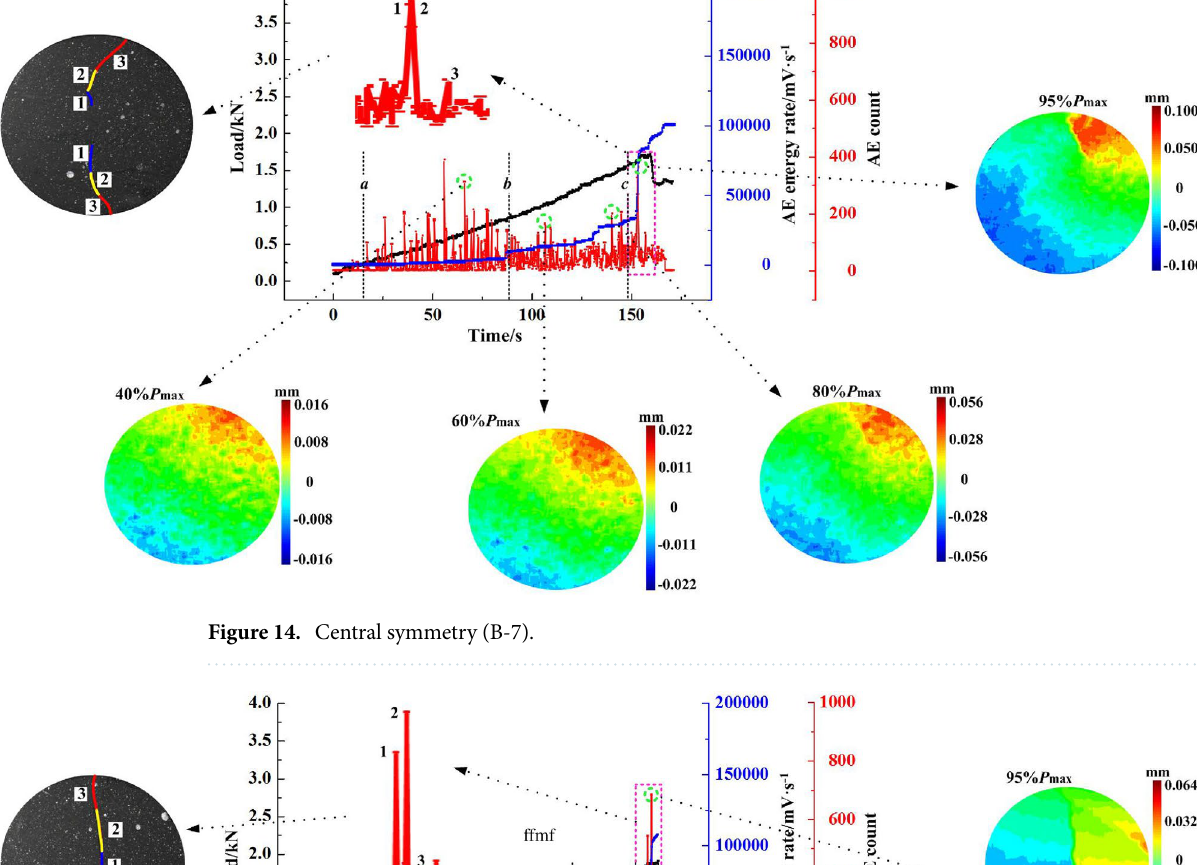
Figure 14. Central symmetry (B-7).